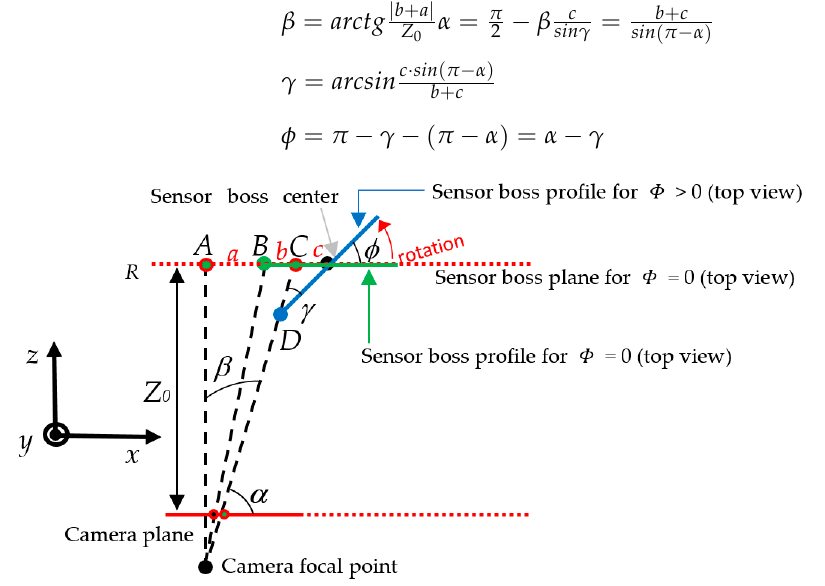
Figure 7. Geometrical model for rotation shifts.